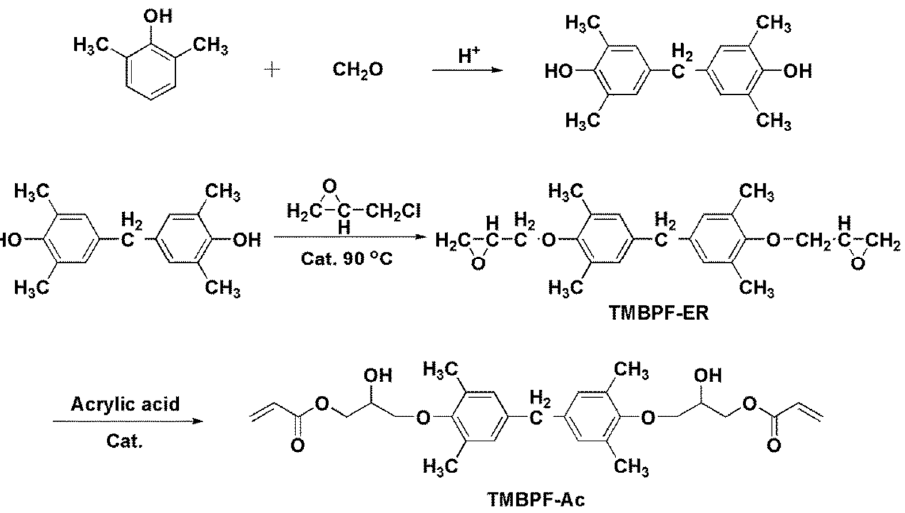
Figure 1. Illustration of the complete synthesis of TMBPF-Ac under the necessary conditions and reprinted with permission published work of Hong, L. et al. [60].